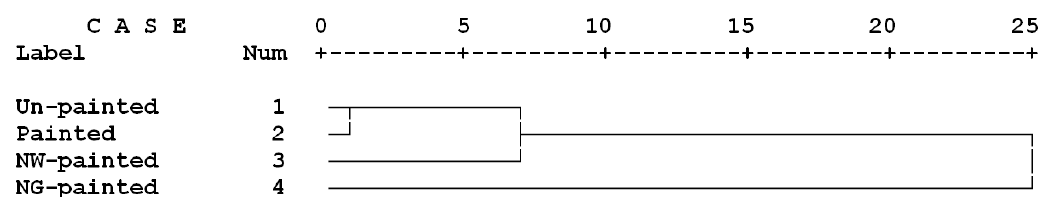
Figure 9. Cluster analysis among the four treatments of beech specimens based on all the fire properties studied in the present project (NW = nano-wollastonite; NG = nano-graphene).